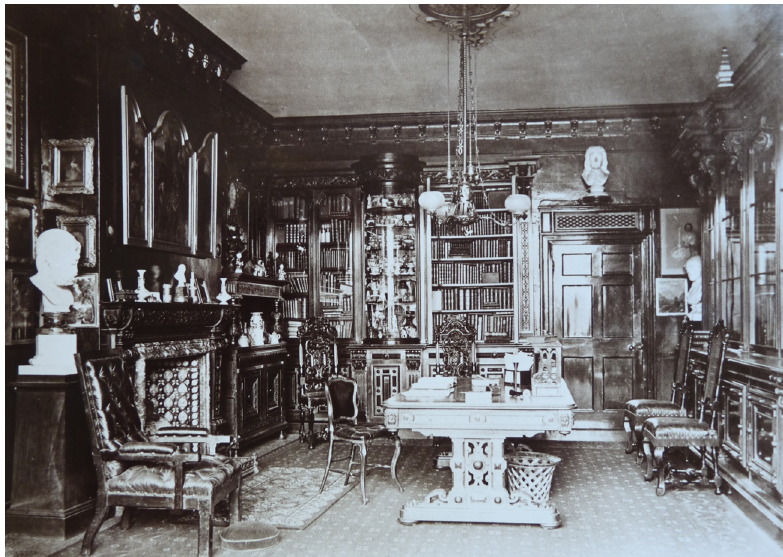
Figure 4: Elizabethan Library at Claremont (Yorkshire Archaeological